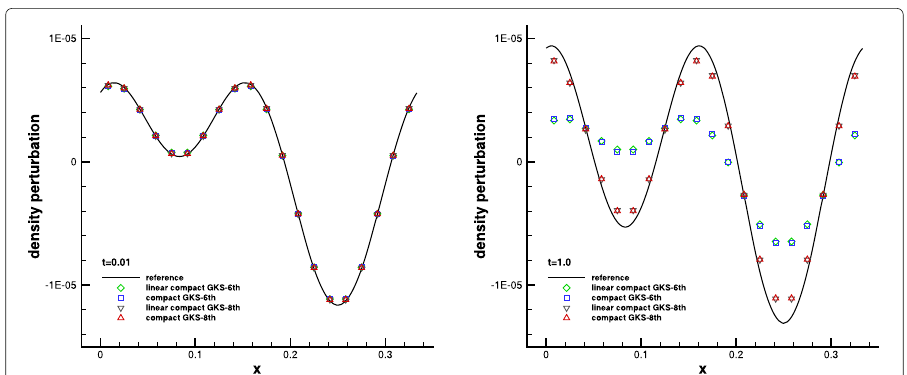
Fig. 8 One-dimensional acoustic problem: the distributions of density perturbation obtained by compact GKS at t = 0.01 (left, 1 period) and t = 1.0 (right, 100 periods) with 20 mesh points. The ratio of non-dimensional initial density wavelength to sound speed is λ ρ